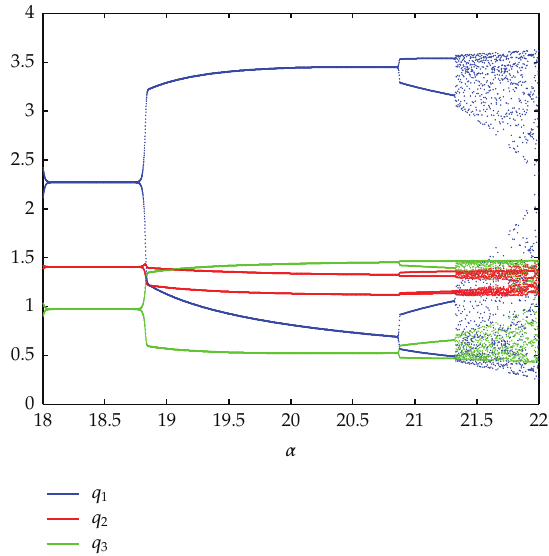
Figure 5: Bifurcation diagram for β (cid:7) 0 . 4.